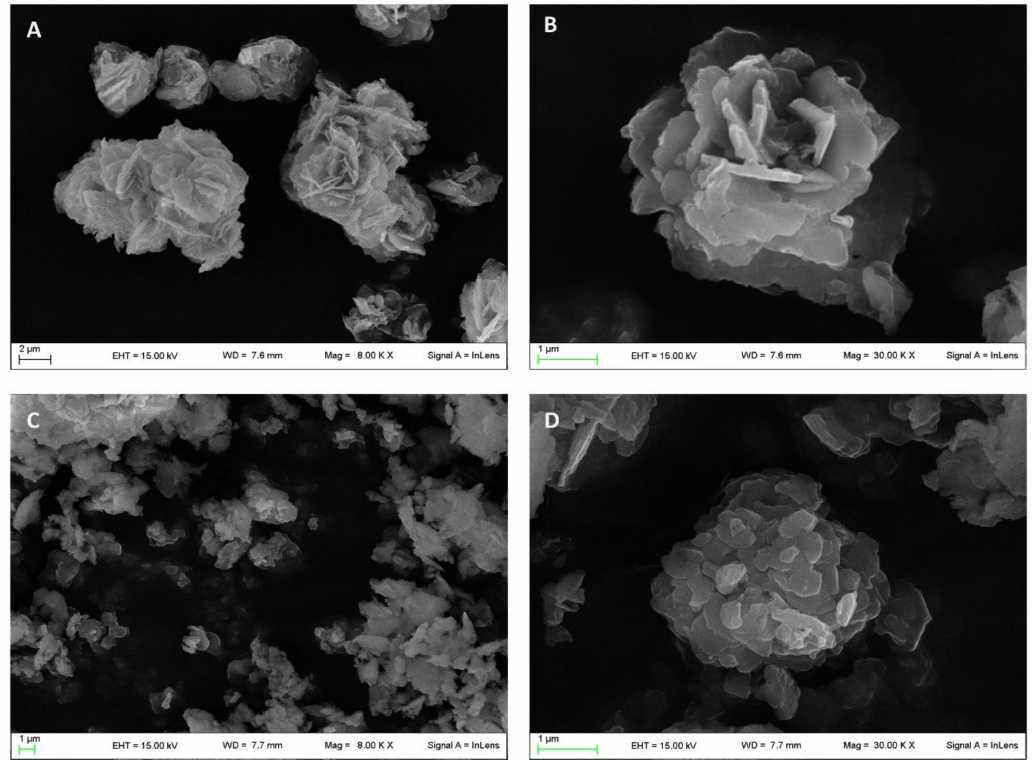
Figure 2. Micrographs obtained by scanning electron microscopy of pristine ZnAl-NO 3 ( A , B ) and ZnAl-KET ( C , D